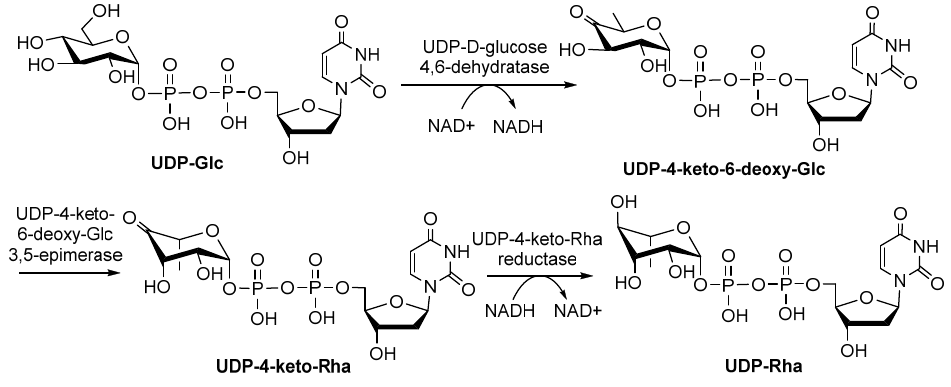
Figure 8. Biosynthesis pathway of UDP-Rha [22].